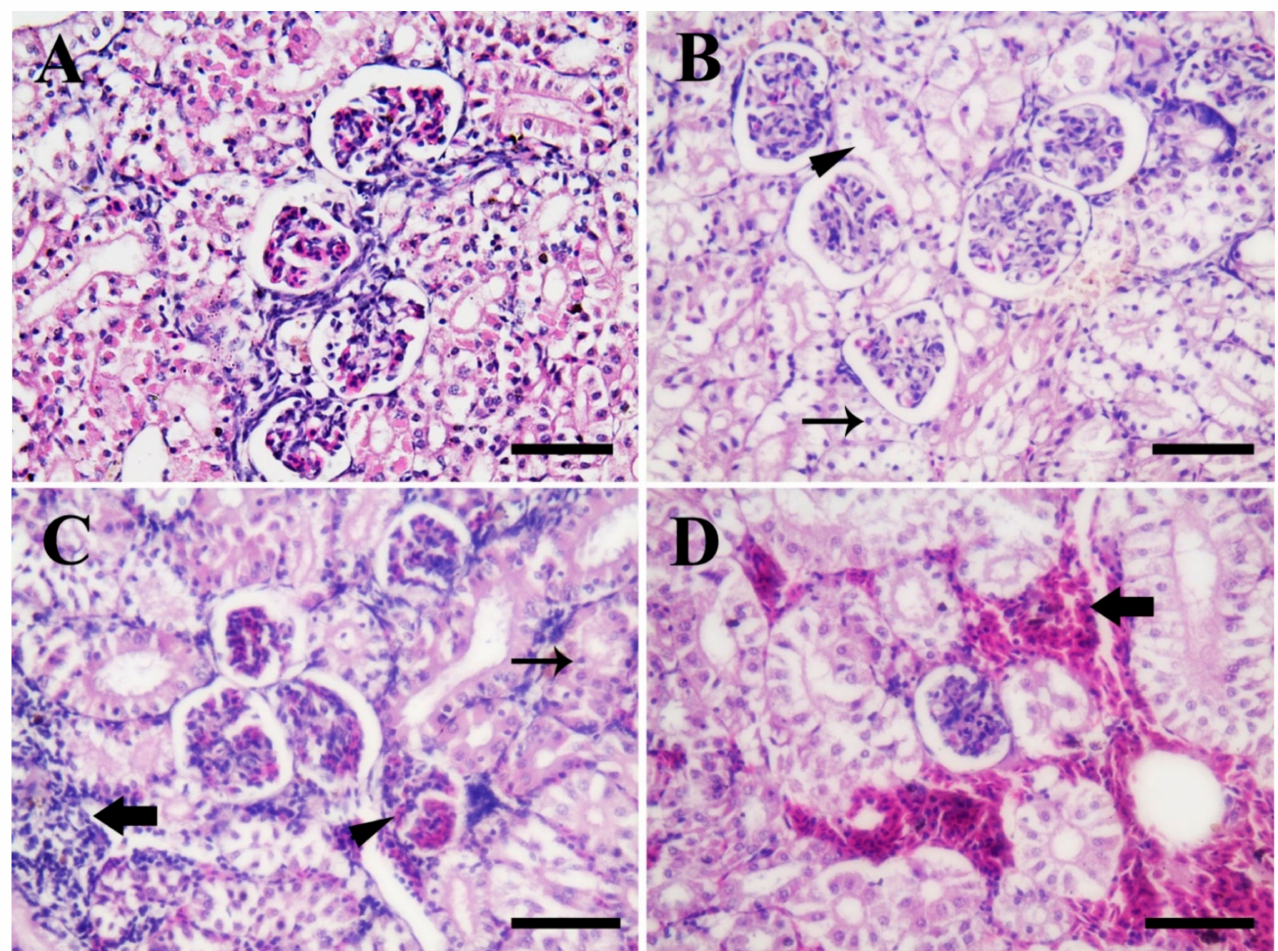
Figure 8. Illustrative photomicrographs of the posterior kidneys of Nile tilapia (H & E stain, scale bar = 50 µ m) from the control group ( A ), and fish groups exposed to SiO 2 NPs at 20 mg/L ( B ), 40 mg/L ( C ), and 100 mg/L ( D ), respectively, for 3 weeks. ( A ) Normal renal architecture. ( B ) Slight necrosis of several renal tubules and edema (arrowhead), as well as pyknotic nuclei (arrow). ( C ) Moderate necrosis of some renal tubules and edema (thin arrow), congested glomeruli (arrowhead), and extensive filtration of inflammatory cells (thick arrow). ( D ) Extensive inter-tubular hemorrhages